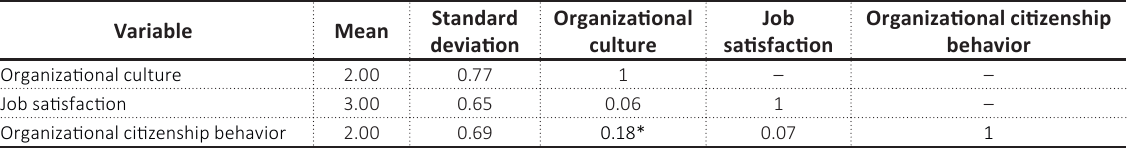
Table 1. Mean, standard deviation, and correlation